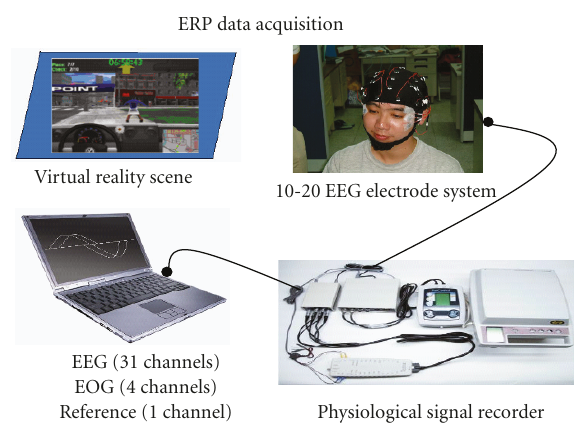
Figure 1: Physiological signal measurement system in the VR-based tra ffi c-light simulation